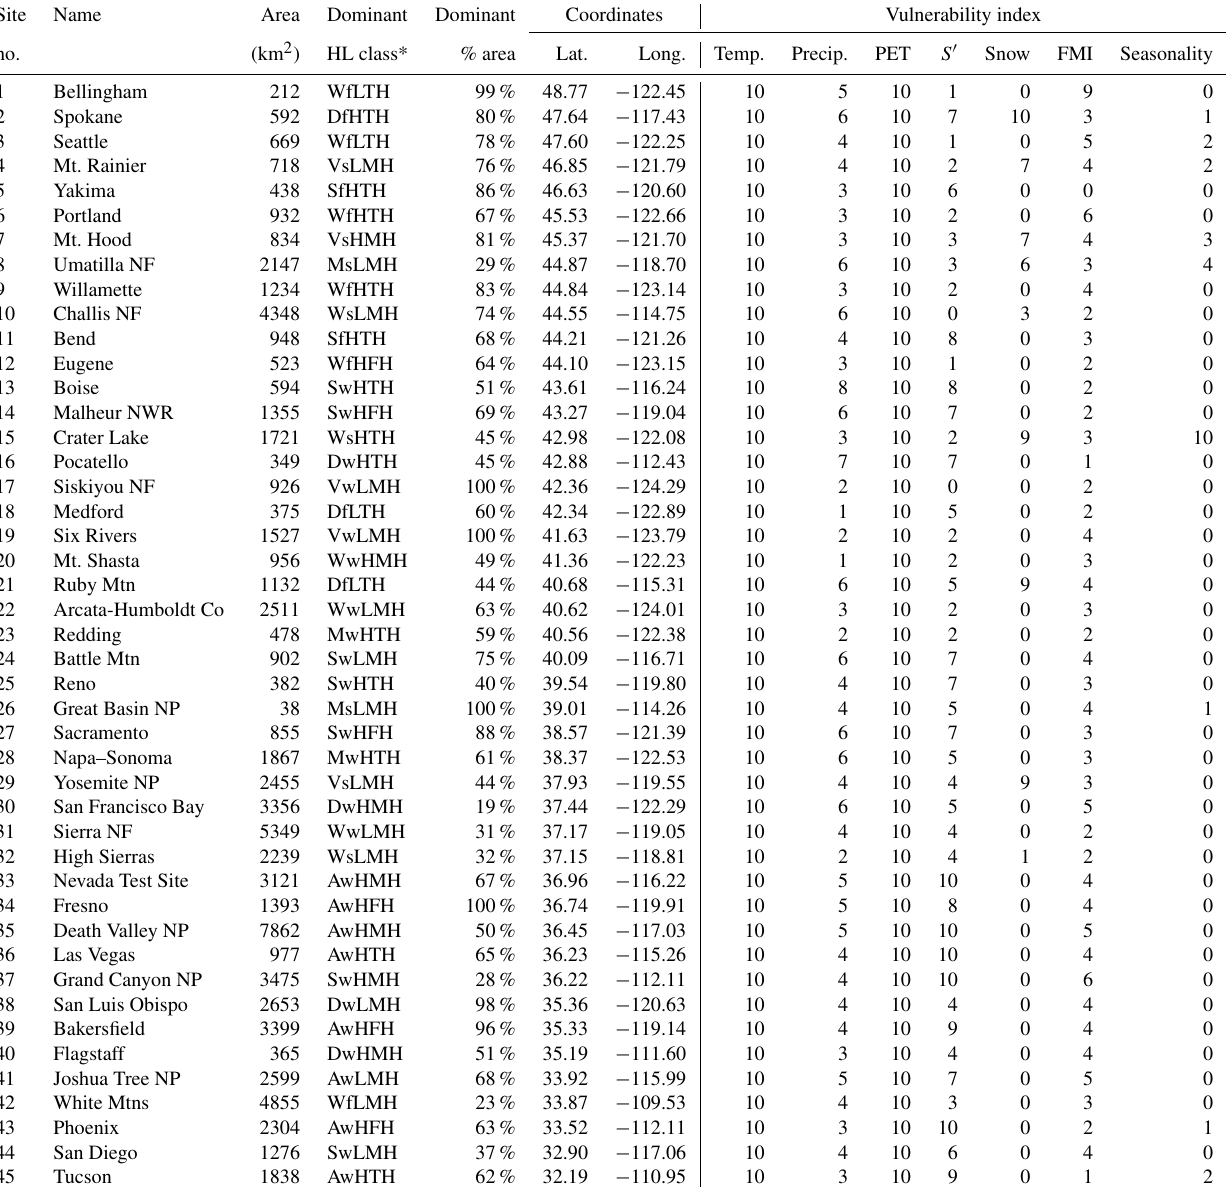
Table 2. Summary table for 45 study locations (sorted by decreasing latitude) providing a numeric ID from Fig. 1, total analysis area, dominant HL class (representing climate, seasonality, subsurface permeability, terrain, and surface permeability), percent area represented by the dominant HL class, latitude and longitude of the center point of the area, and vulnerability indices for temperature, precipitation, potential evapotranspiration (PET), surplus water ( S (cid:48) ), snow water equivalent (snow), Feddema Moisture Index (FMI), and